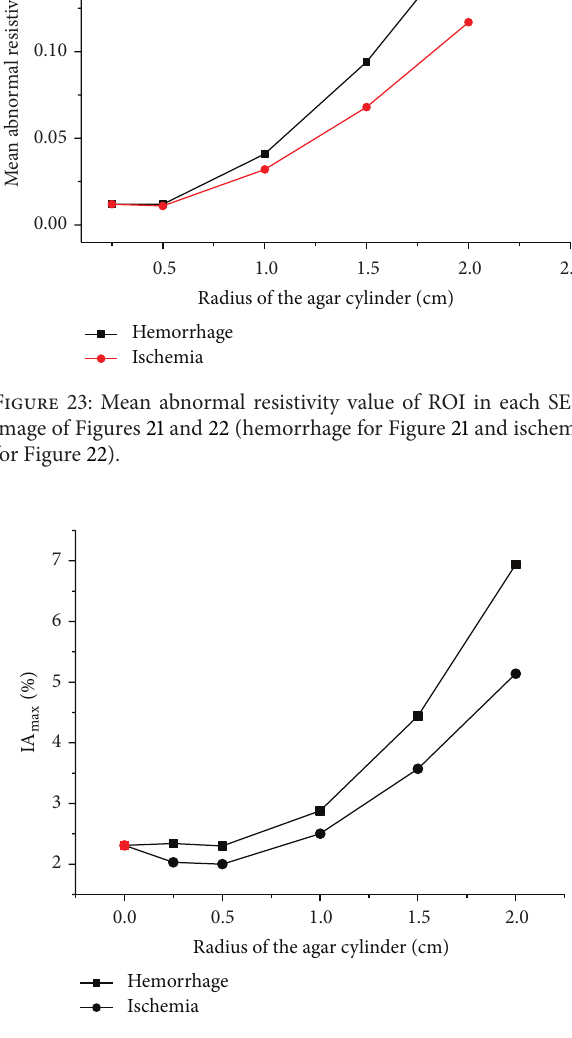
Figure 24: IA max of EIT data from the two hemispheres of the phantom with and without a simulated hemorrhagic or ischemic stroke lesion. Black points represent IA max with a simulated stroke lesion, while the red point represents IA max without a simulated